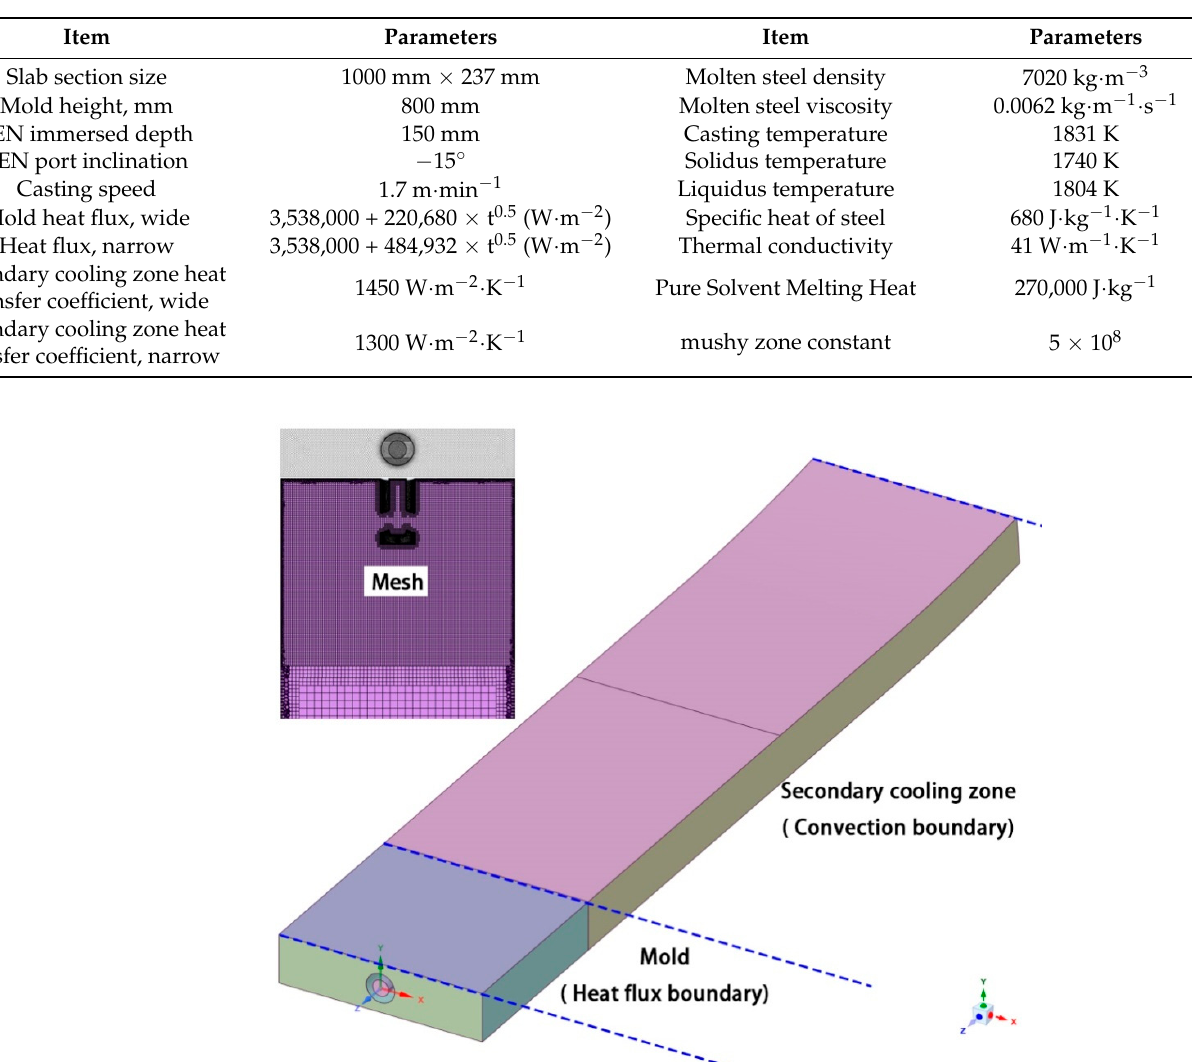
Table 1. Geometry dimensions and simulation conditions.